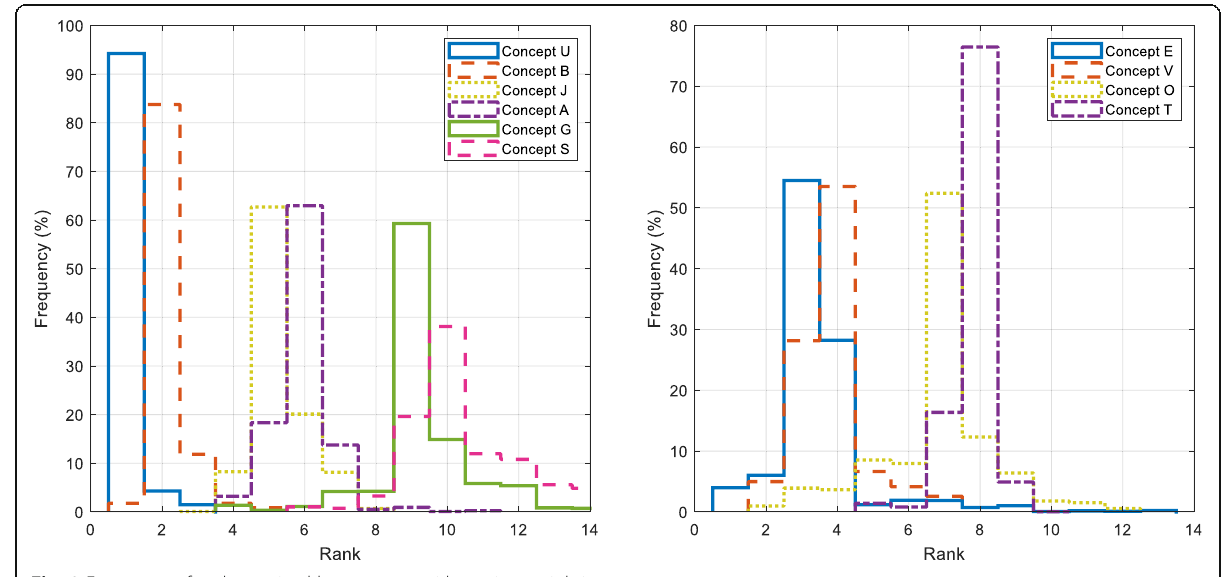
Fig. 8 Frequency of ranks received by concepts with varying